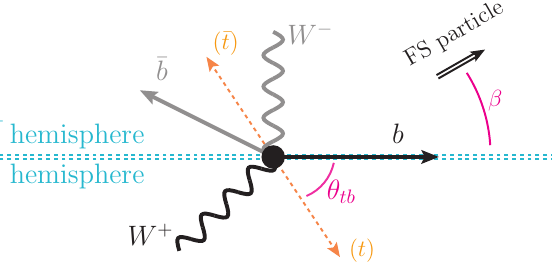
Figure 8: Illustration of the definitions of the angles θ of the t and ¯ t hemispheres.